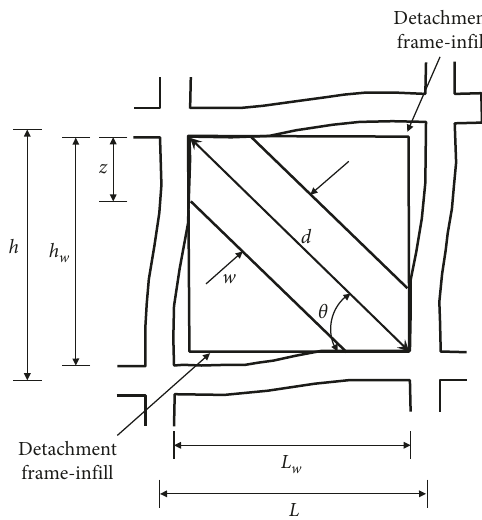
Figure 12: Equivalent diagonal strut